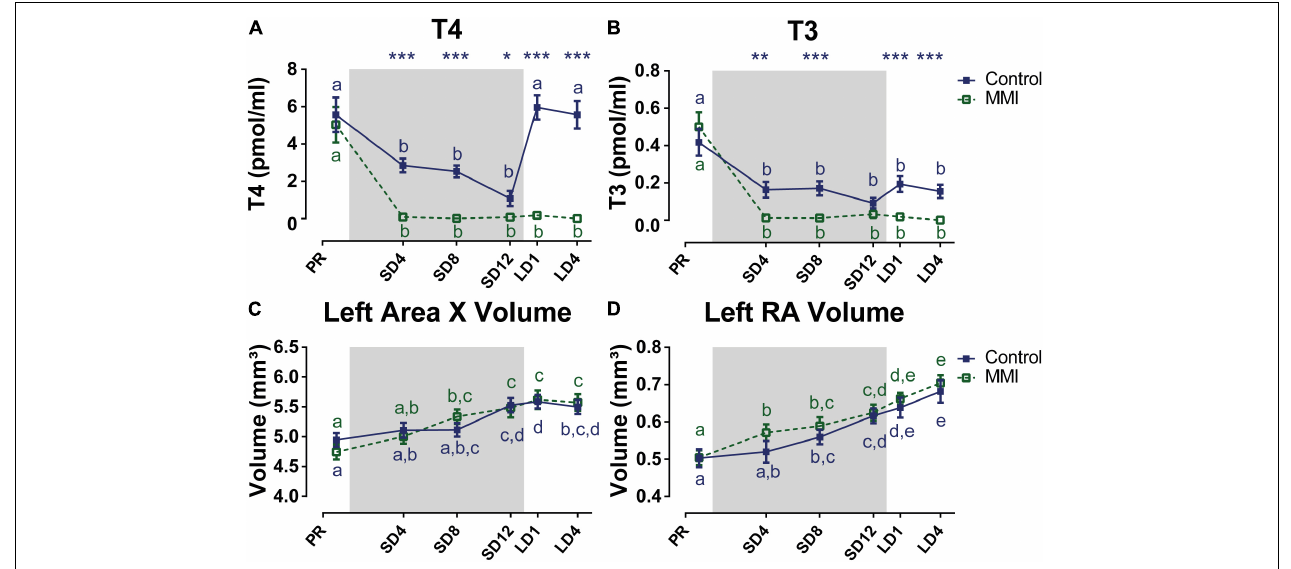
FIGURE 4 | Overview of the seasonal changes in plasma levels of thyroid hormones T4 (A) , T3 (B) , and Area X (C) , and RA volume (D) in control and MMI-treated starlings. Solid and dashed lines represent the group average of control and MMI-treated starlings respectively with standard errors of the mean error bars. The gray area indicates the photosensitive period of short days (8L:16D). Different letters denote significant differences by comparison with each other in post-hoc t -tests with p < 0.05 (Tukey’s HSD correction for multiple comparisons) comparing the different time points to each other. If two time points share a common letter, the thyroid hormone levels, Area X or RA volumes are not significantly different from each